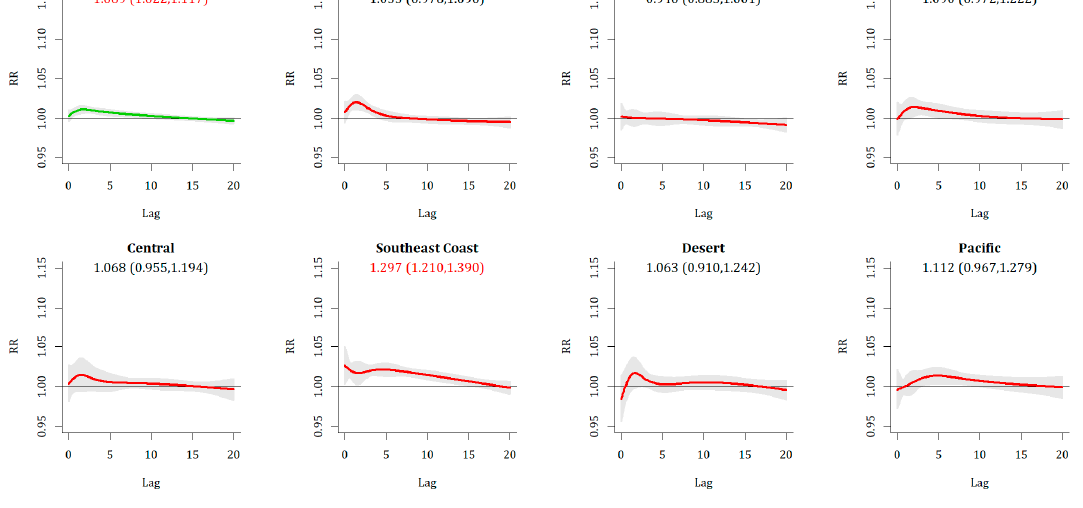
Figure 4. Same as Figure 2, except for RECE.